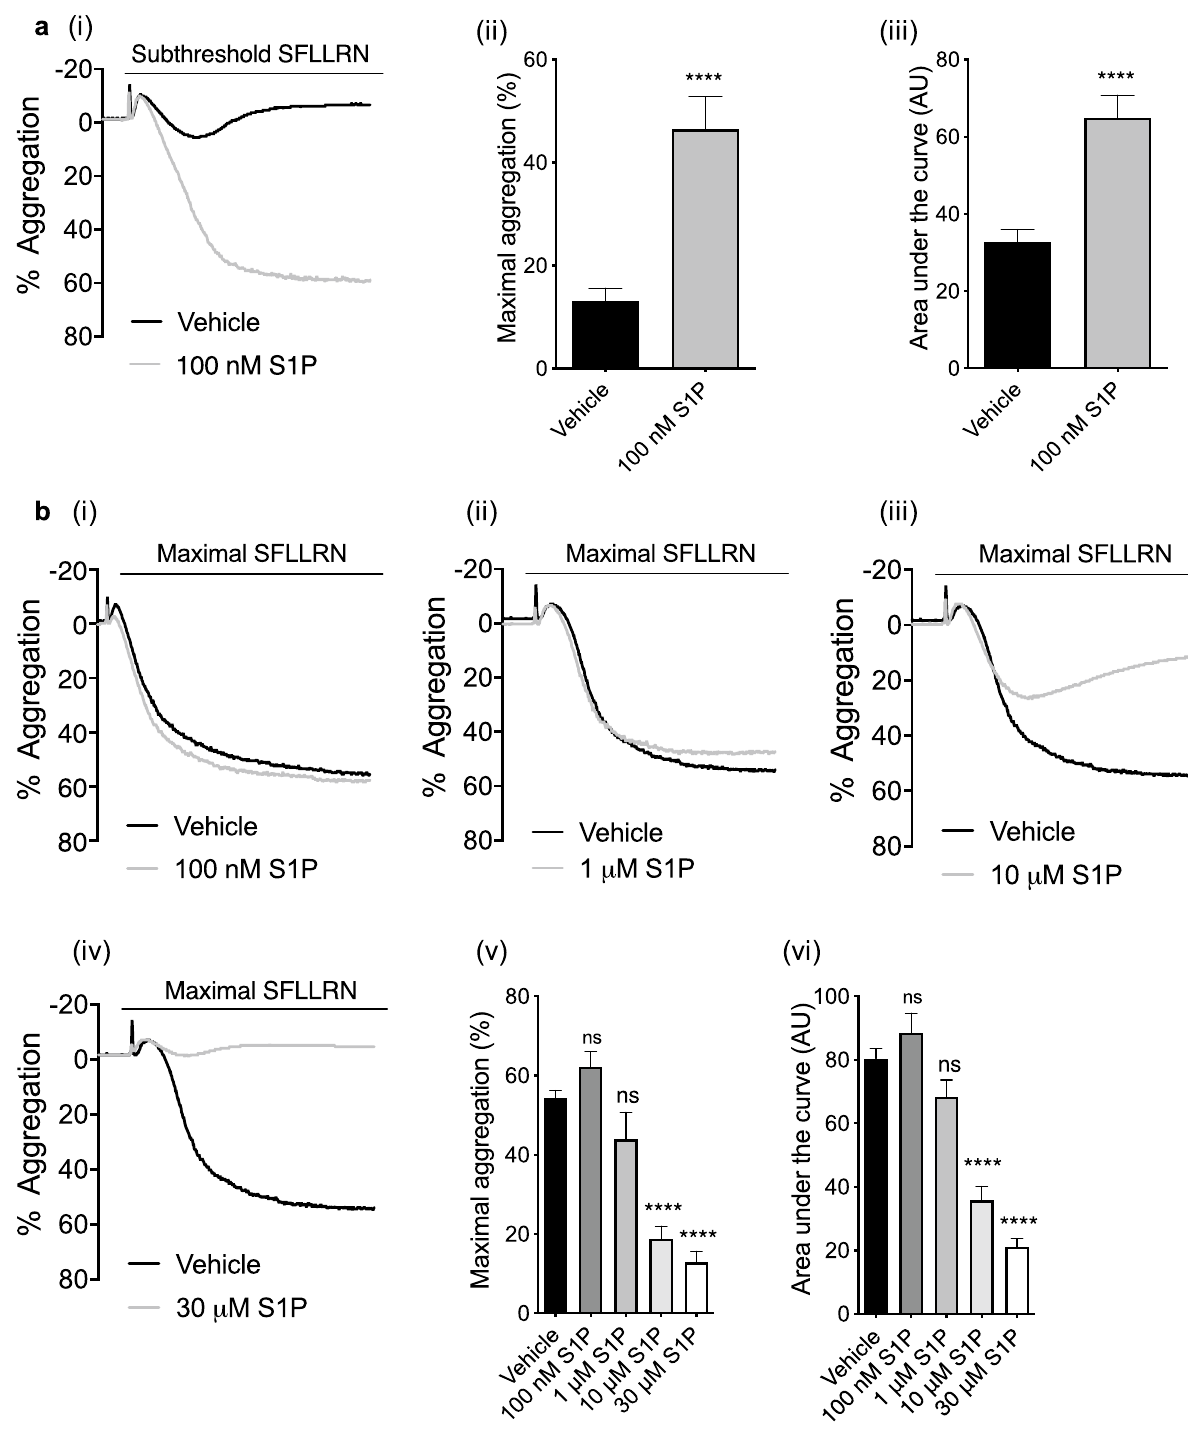
Figure 1. S1P modulates PAR1-AP induced platelet aggregation in a concentration dependent biphasic manner. Washed human platelets (2 × 10 8 /mL) were pre-incubated with vehicle (0.2% methanol), 100 nM S1P and high concentrations of S1P for 5 min. Platelet aggregation was induced by subthreshold (0.6–1.0 μM) or maximal (1.5–2.0 μM) concentrations of PAR1-AP and recorded for 5 min. ( a ) (i) Representative traces of subthreshold and maximal aggregation induced by PAR1-AP in the absence or presence of 100 nM S1P. (ii) Bar graph of quantified percentage maximum aggregation induced by PAR1-AP alone or with the presence of 100 nM S1P. (iii) Bar graph of AUCs induced by PAR1-AP alone or with the presence of 100 nM S1P. AU: arbitrary unit. Data are plotted as mean ± standard error of the mean. N = 17 Statistical analysis: Student’s paired t-test. NS, no statistical significance. **** P < 0.0001 ( b ) (i–iv) Representative traces of aggregation induced by maximal concentration of PAR1-AP in the absence or presence of 100 nM, 1 μM, 10 μM and 30 μM S1P. (v) Bar graph of quantified percentage maximum aggregation induced by high PAR1-AP alone or in the presence of various concentrations of S1P (100 nM, 1 μM, 10 μM, 30 μM). (vi) Bar graph of AUCs induced by high concentration PAR1-AP alone or in the presence of various concentrations of S1P (100 nM, 1 μM, 10 μM, 30 μM). Data are plotted as mean ± standard error of the mean. n = 12. Statistical analysis: Student’s paired t-test. NS, no statistical significance; **** P <